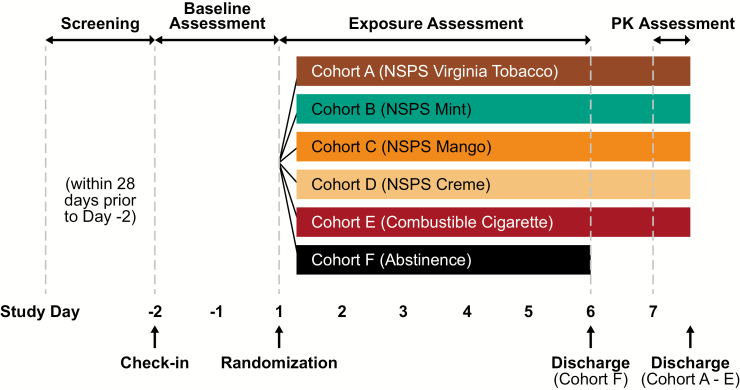
Overall study design.